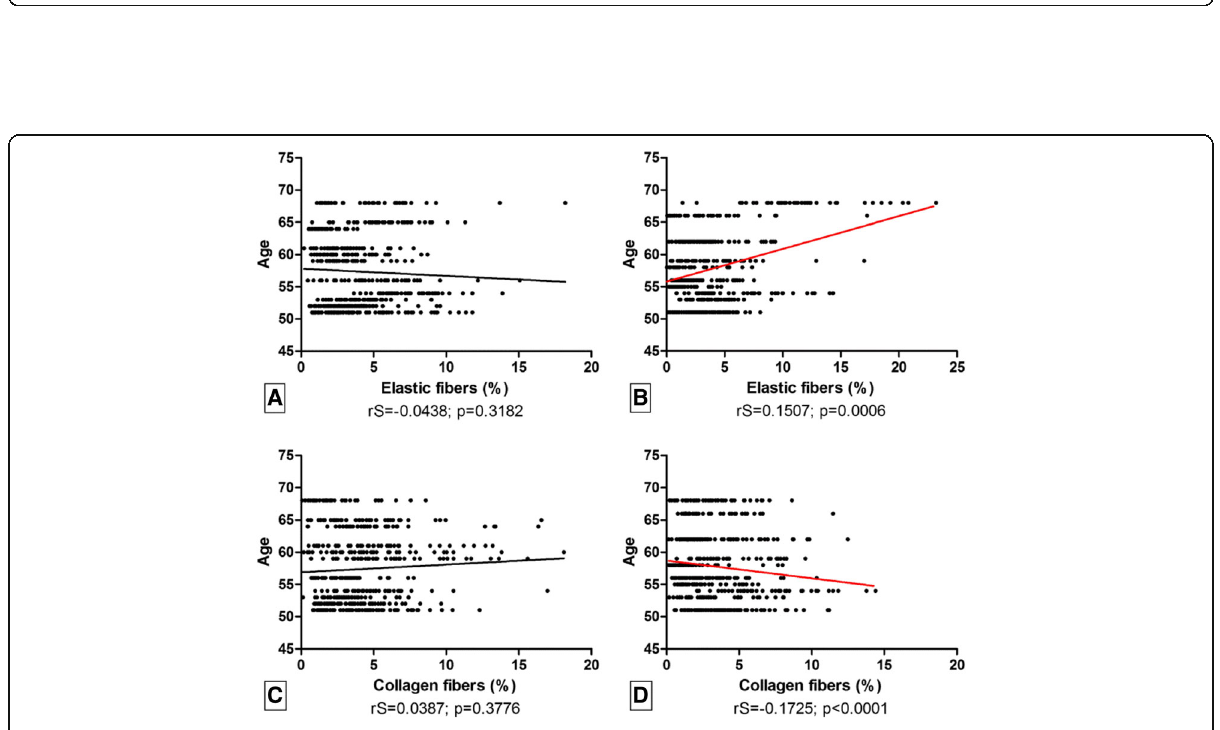
Fig. 5 a Correlation between elastic fibers percentage and age in Aids group. b Correlation between elastic fibers percentage and age in non- Aids group. c Correlation between collagen fibers percentage and age in Aids group. b Correlation between collagen fibers percentage and age in non-Aids